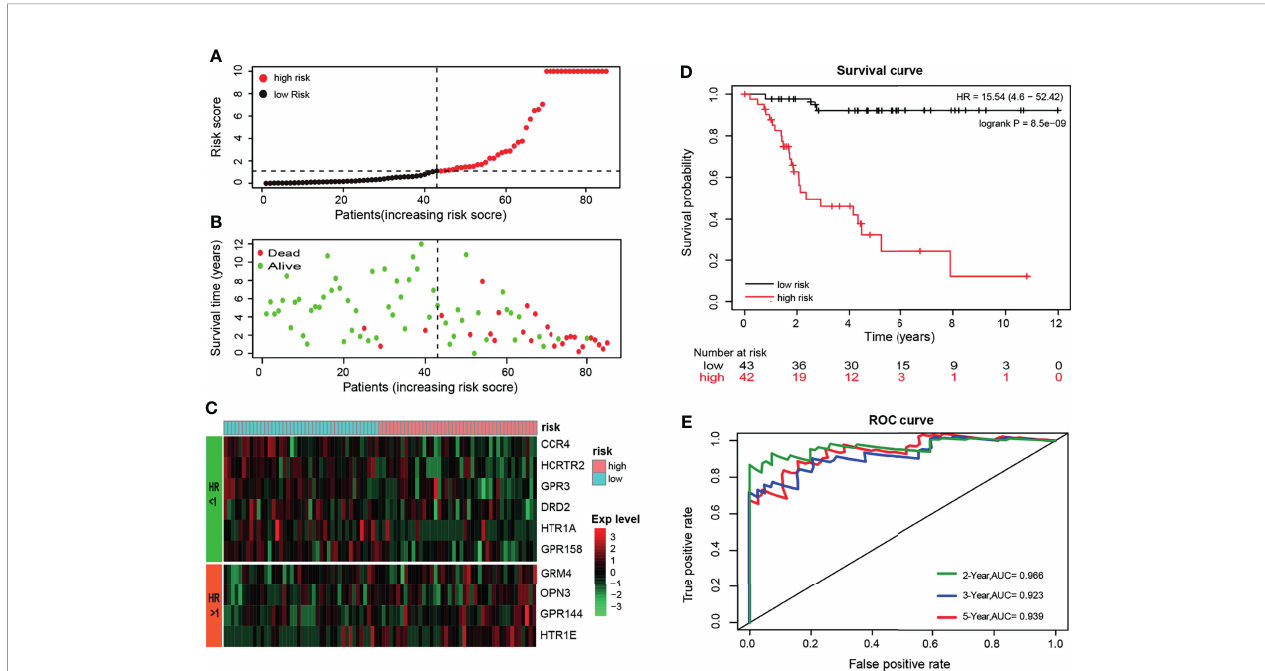
FIGURE 4 | (A) Sort the patients by risk-score, black ’ dot and red ’ dot represent the low-risk group and high-risk group respectively, and the dashed line represents the median risk score. (B) Sort the patients by risk score, green and red represent alive and dead respectively, and the dashed line represents the median risk score. (C) The heat map shows the expression levels of the 10-GPCRs. (D) Kaplan-Meier survival curve distribution of the OS patients (p < 0.001). (E) ROC curve of the model and the green, blue, red curve represents the rate of correct prediction in 2, 3, 5